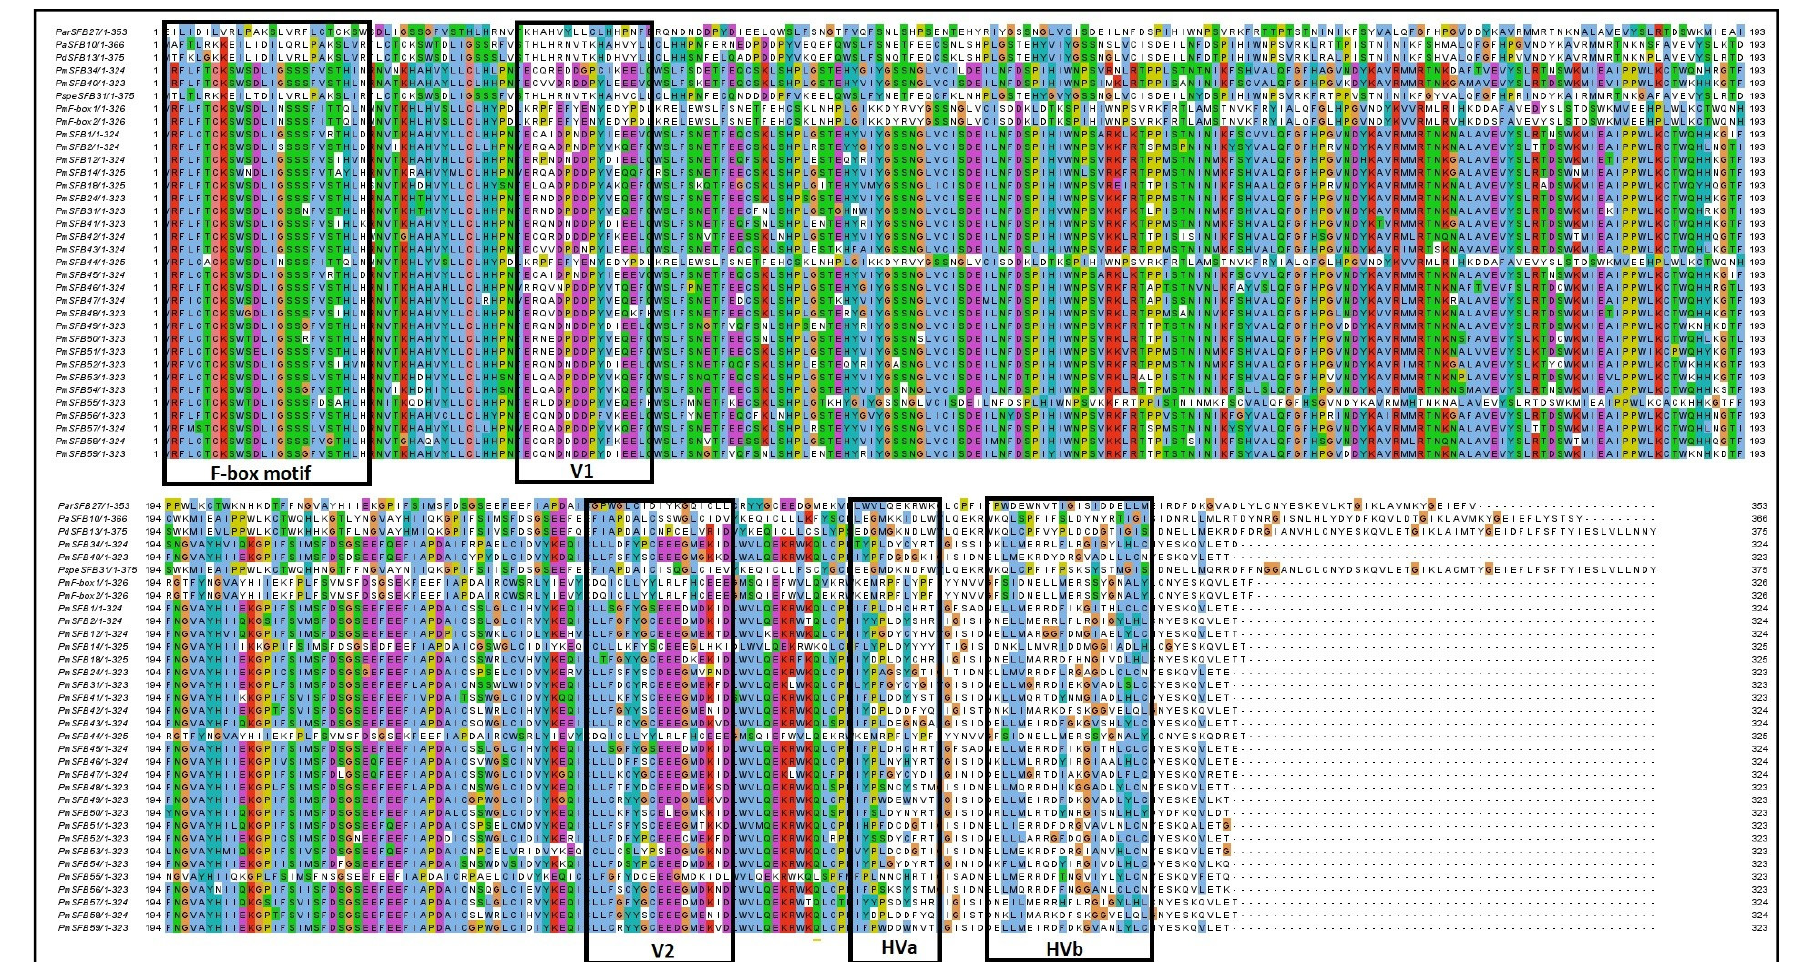
Figure 3. The amino acid sequences of Prunus armeniaca ( Par ), Prunus avium ( Pa ), Prunus dulcis ( Pd ), Prunus speciosa ( Pspe ), and Prunus mume ( Pm ) SFB genes source comparison. The dark areas show conserved residues and dots indicate gaps. The F-box domain, variable regions (V1 regions, V2 regions), and hypervariable regions (HVa regions and HVb regions) are, respectively, circled with boxes and marked.